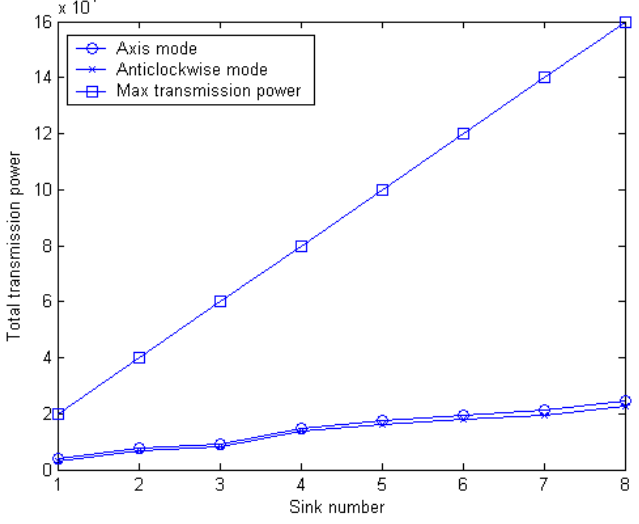
Figure 16. Total transmission power at different sink numbers